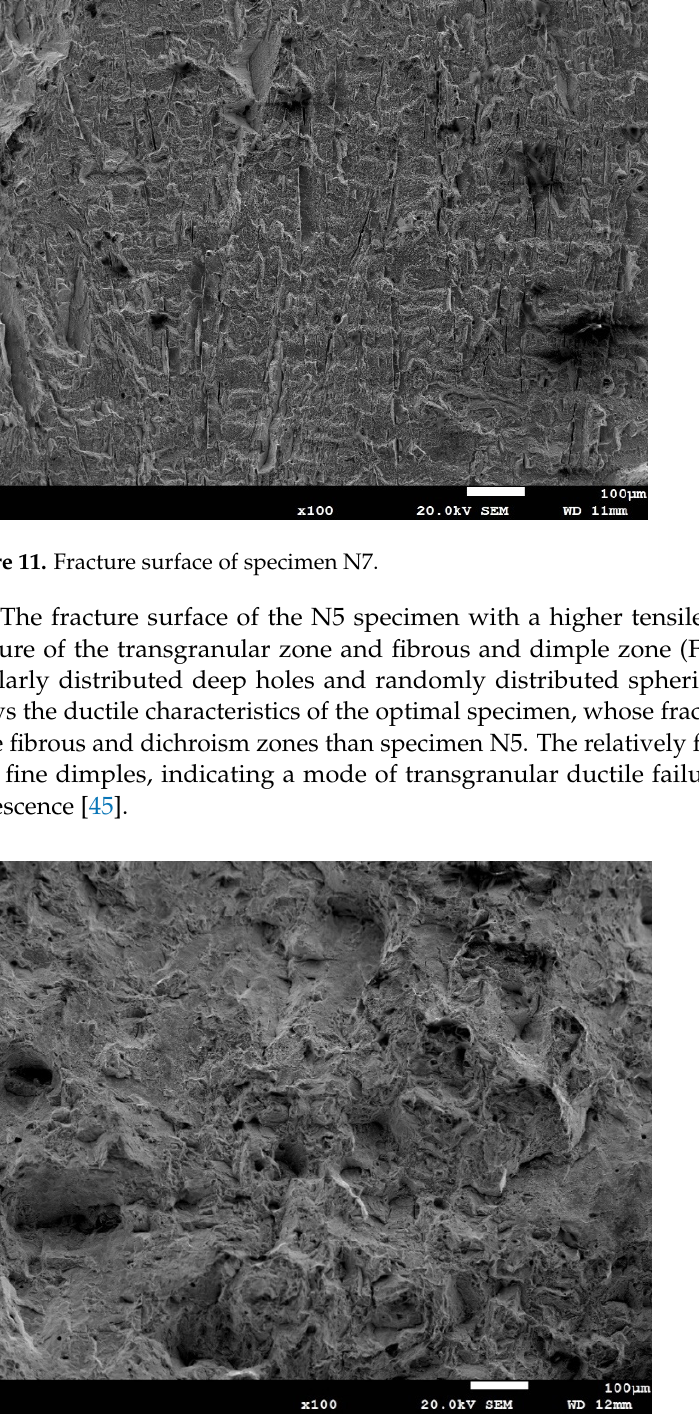
Figure 10. 3D metallograph of optimal specimen.